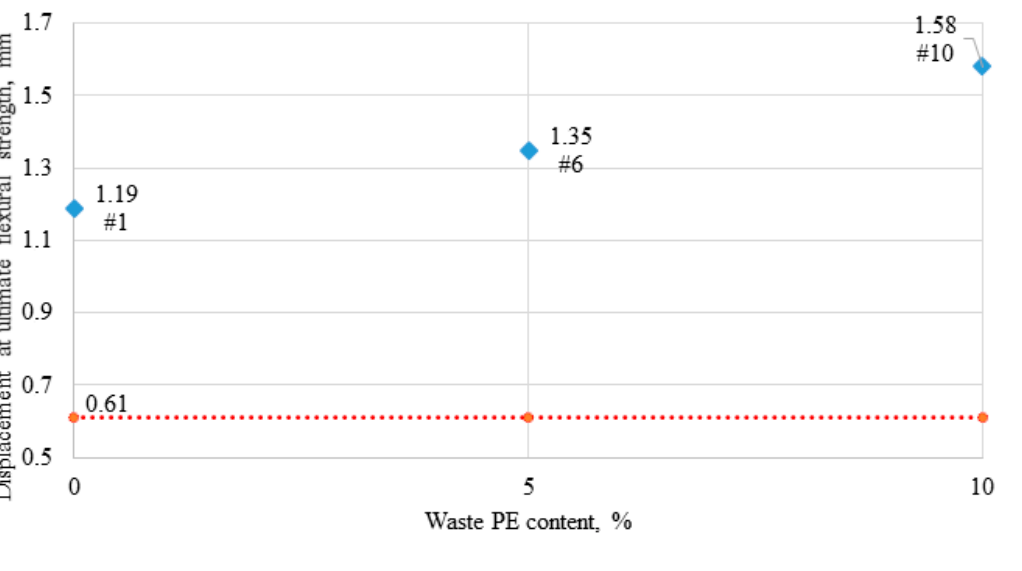
Figure 11. Displacement at ultimate flexural strength depending on the PE waste content, designated at experiment plan points numbered 1, 6, and 10.